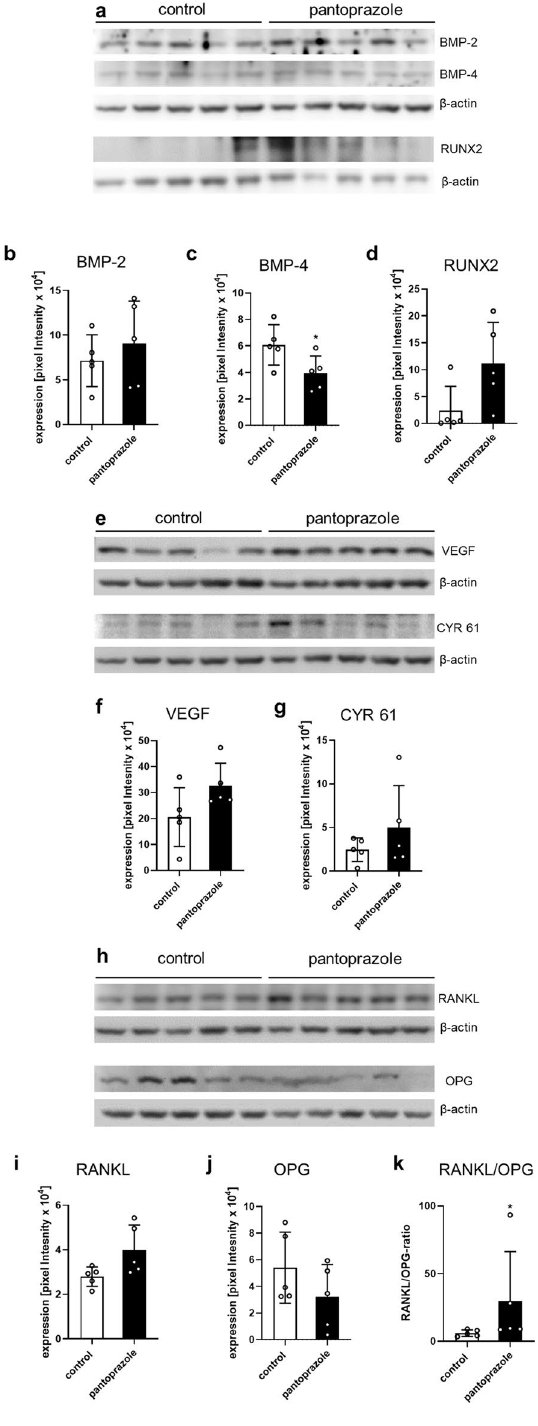
Figure 7. Western blot analysis of mice femora (1). Western blot analysis of the expression of the bone formation markers BMP-2 ( a , b ), BMP-4 ( a , c ) and RUNX2 ( a , d ), the pro-angiogenic factors VEGF ( e , f ) and CYR 61 ( e , g ), the osteoclastogenesis stimulator RANKL ( h , i ) and the osteoclastogenesis inhibitor OPG ( h , j ) in the callus of controls (white bars) and pantoprazole-treated animals (black bars) at 2 weeks after fracture healing. ( k ) displays the RANKL/OPG-ratio in the callus of controls (white bars) and pantoprazole-treated animals (black bars). Means ± SD; n = 5; *p < 0.05 vs.